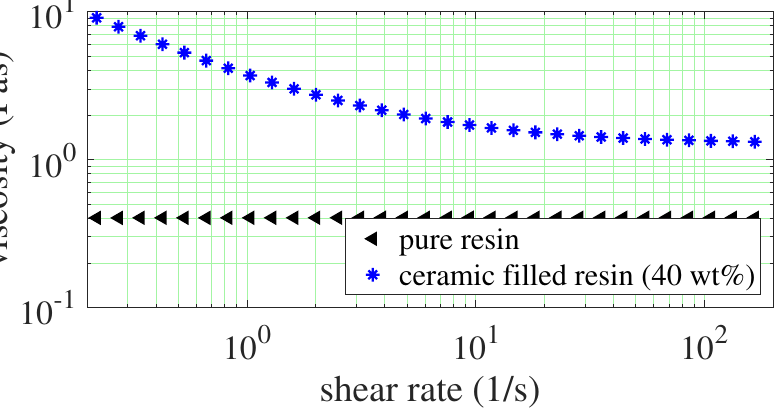
Figure 4. Measured viscosity of the pure resin and the ceramic filled resin (with 40 wt% powder